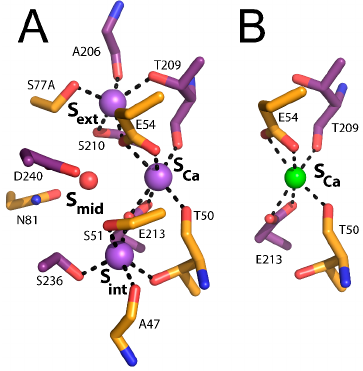
Figure 2. Ion binding sites of NCX_Mj. ( A ) Na + binding sites (PDB 5HXE); ( B ) Ca 2+ binding site (PDB 3V5U). Ion coordinating residues are presented as sticks. Purple and green spheres represent Na + and Ca 2+ ions, respectively.